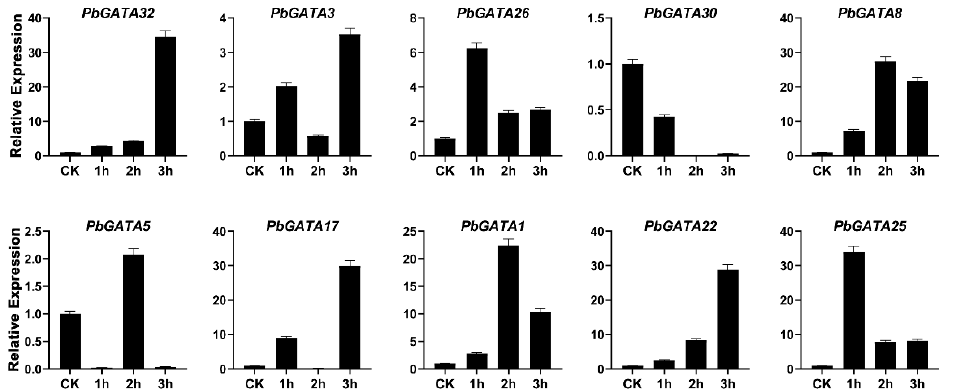
Figure 13. Expression profiling of GATA gene family analyzed by qRT-PCR in the fruit of Chinese pear at the developmental stage after hormonal treatment of methyl jasmonate (MeJA) and CK represents control. Error bars represent the standard error (SE) of three biological replicates.